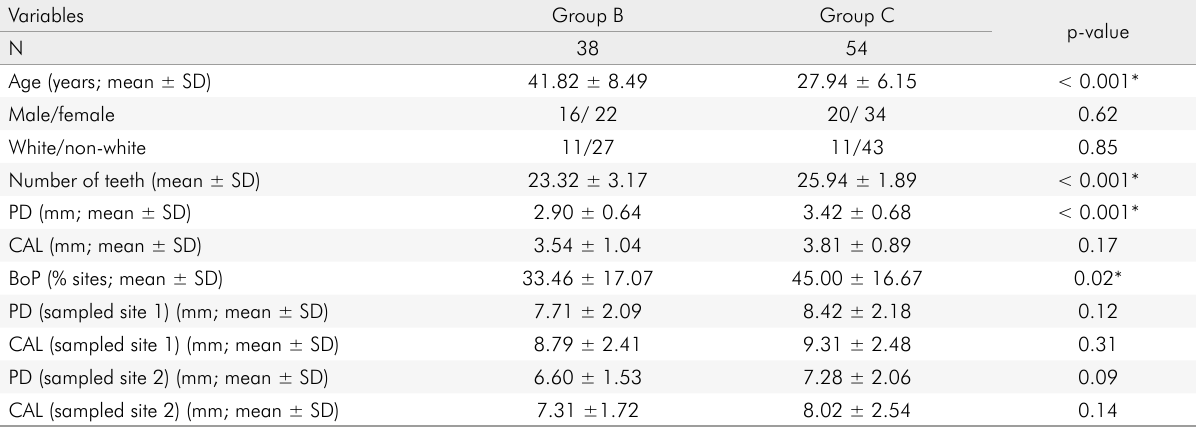
Table 2. Characteristics of the study participants.